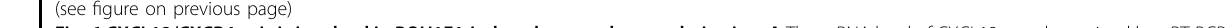
Fig. 6 CXCL12/CXCR4 axis is involved in POU1F1-induced macrophage polarization. A The mRNA level of CXCL12 was determined by qRT-PCR. GAPDH served as an internal control. B The correlation between CXCL12 and POU1F1 in GC was determined by Pearson correlation analysis. C The correlations between CXCL12 and CD206, CD163, CCR2, or CD204 in GC were determined by Pearson correlation analysis. D Cell migration of macrophages was determined by transwell migration assay. E In vitro angiogenesis was monitored by tube formation assay. F The mRNA levels of CD163 and VEGFA were determined by qRT-PCR. GAPDH served as an internal control. G The protein levels of p-CXCR4, CXCR4, p-Akt, Akt, p-VEGFR2, and VEGFR2 were determined by western blot. GAPDH served as a loading control. Data were representative images or were expressed as the mean ± SD of n = 3 experiments. * P < 0.05, ** P < 0.01, *** P <